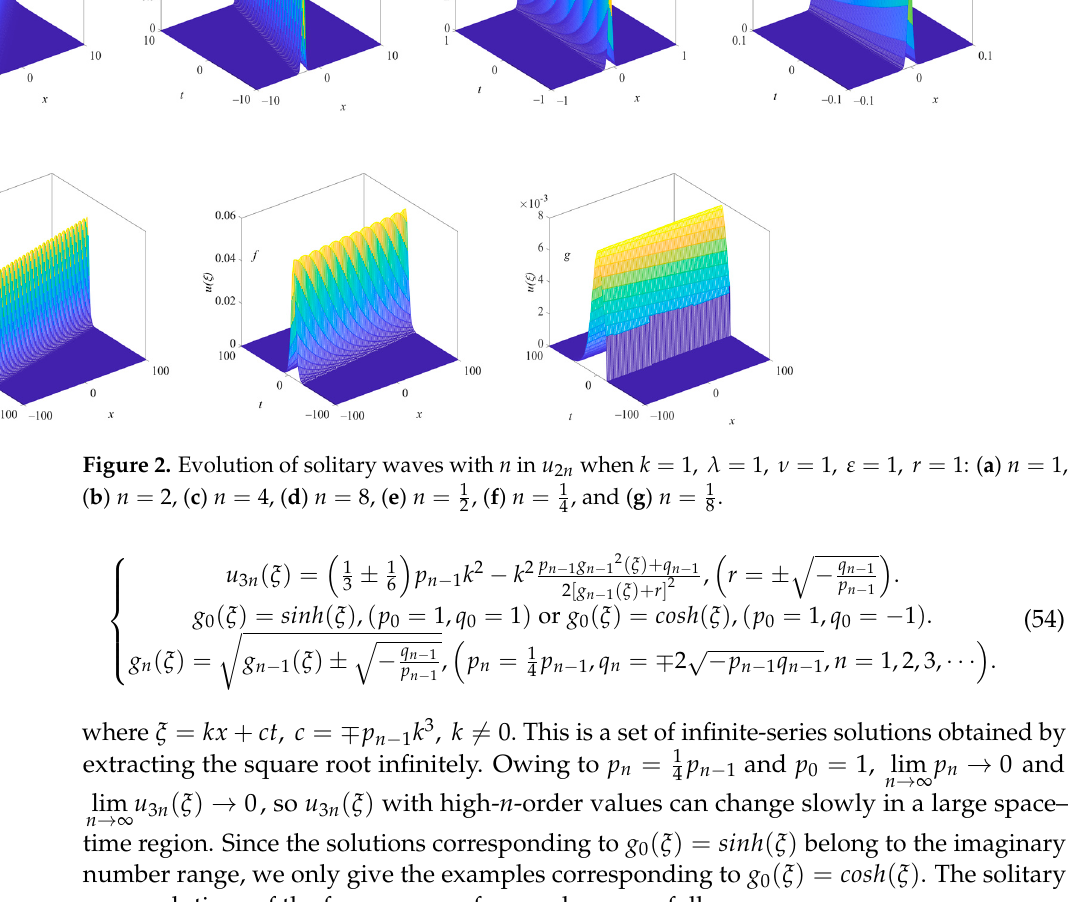
, ( f ) n = 1 , and ( g ) n = 1 , ( f ) 𝑛 = (cid:2869) , and ( g ) 𝑛 = (cid:2869) . 2 8 4 (cid:2870) (cid:2872) (cid:2876)